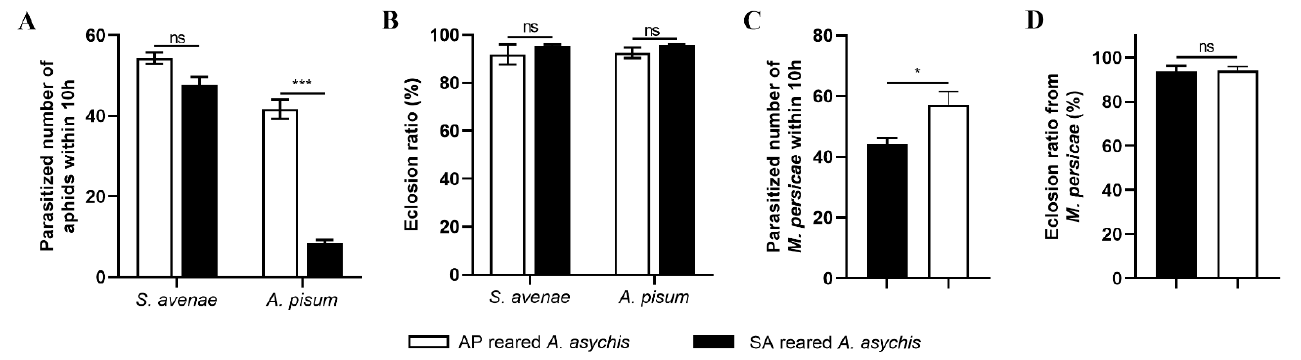
Figure 2. Parasitism of A. asychis emerging from A. pisum (AP-reared A. asychis ) and S. avenae (SA- reared A. asychis ). ( A ) Mean number of aphids parasitized within 10 h by A. asychis reared on nymphs of A. pisum or S. avenae ( n = 3); ( B ) Eclosion rate of A. asychis reared on nymphs of A. pisum or S. avenae from A. pisum and S. avenae ( n = 3); ( C ) Mean number of M. persicae parasitized within 10 h by A. asychis reared on nymphs of A. pisum or S. avenae ( n = 5); ( D ) Eclosion rate of A. asychis reared on nymphs of A. pisum or S. avenae from M. persicae ( n = 5 ). Mean ± SE, Student’s t -test. * means p < 0.05, *** means p < 0.001, and ns means no significant difference.